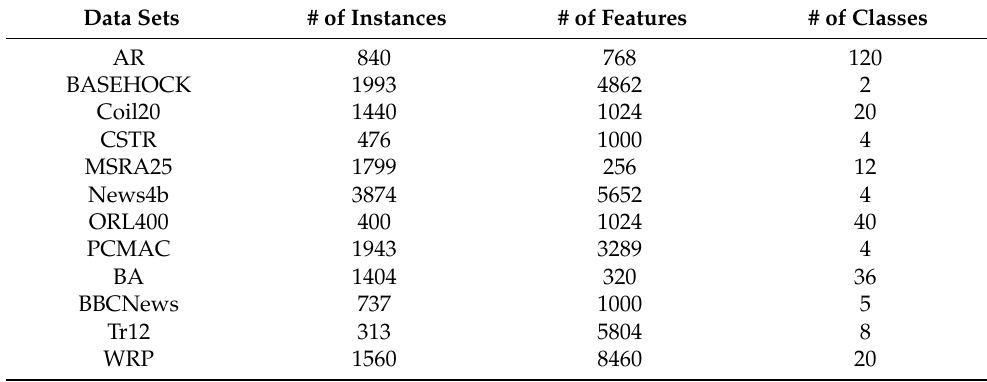
Table 2. Description of the data